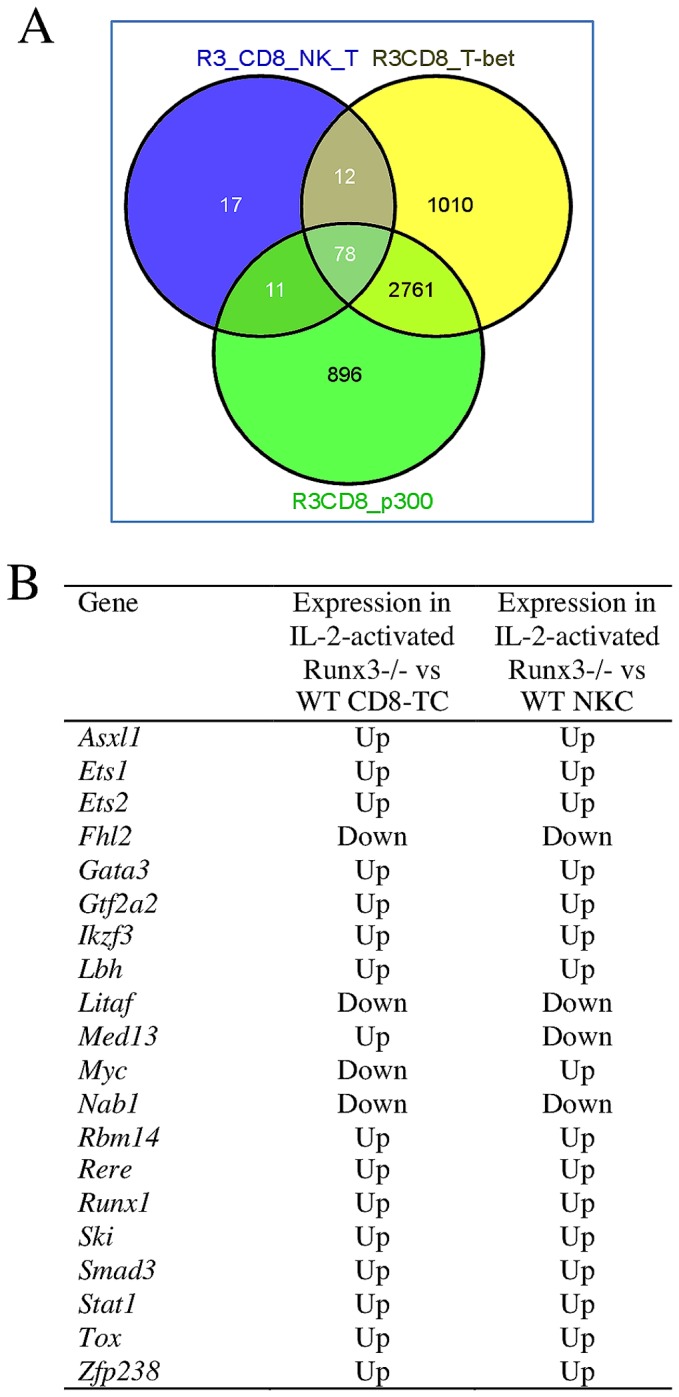
Common Runx3-regulated genes in IL-2-activated CD8-TC/NKC and T-bet/p300 bound genes in Th1.(A) The majority of the 118 common Runx3-regulated genes in IL-2-activated CD8-TC and NKC (R3_CD8_NK_T) harbor overlapping T-bet (R3CD8_Tbet) and p300 (R3_CD8_p300) bound regions in Th1 cells. (B) Transcription factors/regulators that are common Runx3-regulated genes in IL-2-activated CD8-TC and NKC.